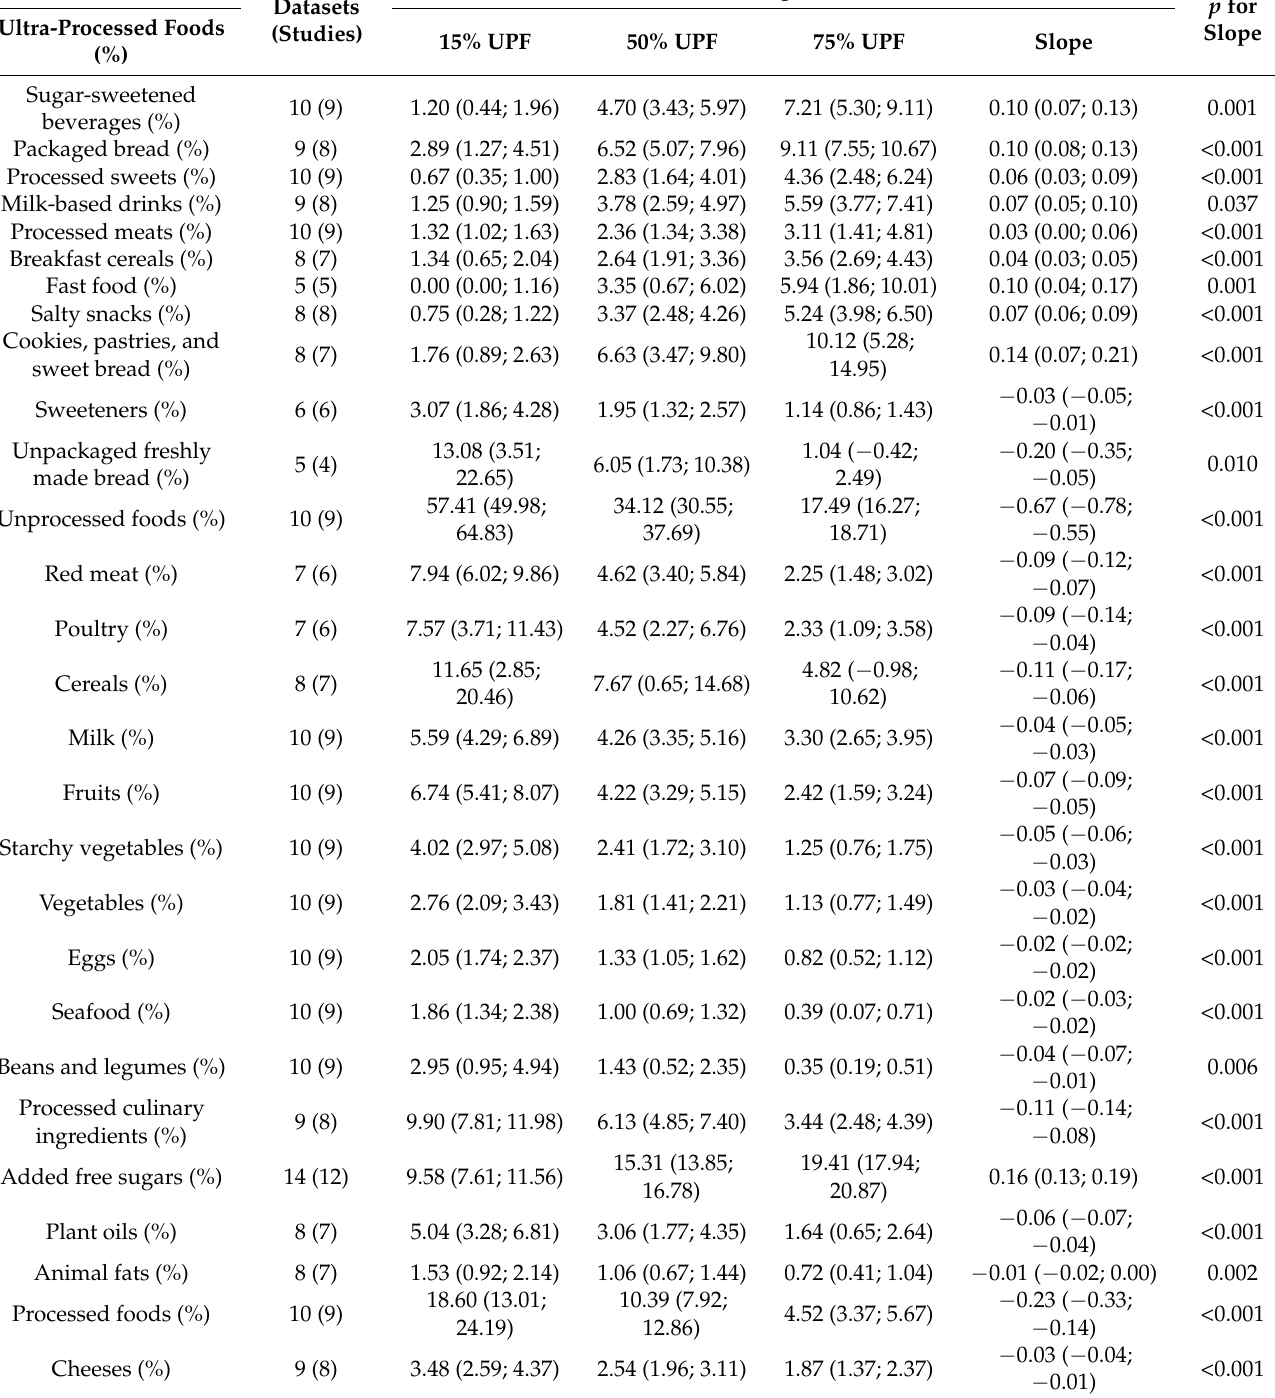
Table 2. Variation in specific food item intake by contribution of ultra-processed foods to total energy consumption and slope of nationally representative samples. Slopes represent the variation in intake of a specific food item when the share of %E from UPFs increased by